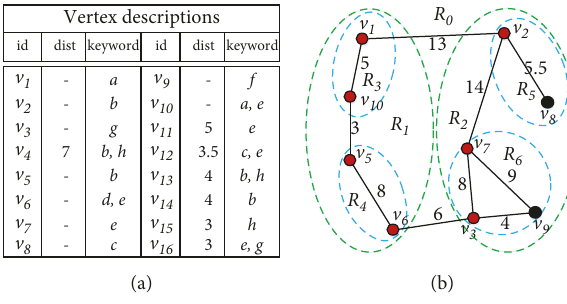
Figure 5: Backbone network structure. (a) Vertex descriptions. (b) Network partition.